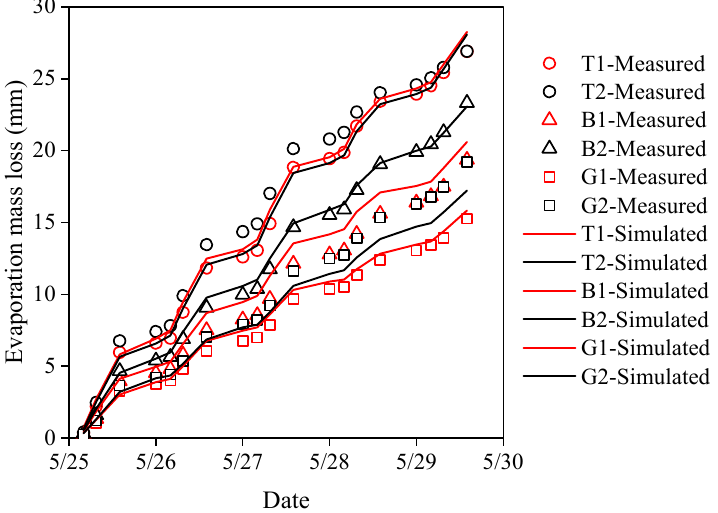
Figure 9. Comparison of simulated and measured evaporation mass losses for the six treatments. A plot of the simulated vs. measured evaporation mass loss yielded a linear relation- ship for all films (Figure 10). A slope lower than 1 was obtained for the larger perforation ratio (0.9554 for T2 and 0.9113 for G2), indicating that the SMAS model slightly underes- timated the evaporation mass losses for the partially covered soil. Comparison with the MRE, RMSE, and IA values for the evaporation rate revealed that the simulated evapora-